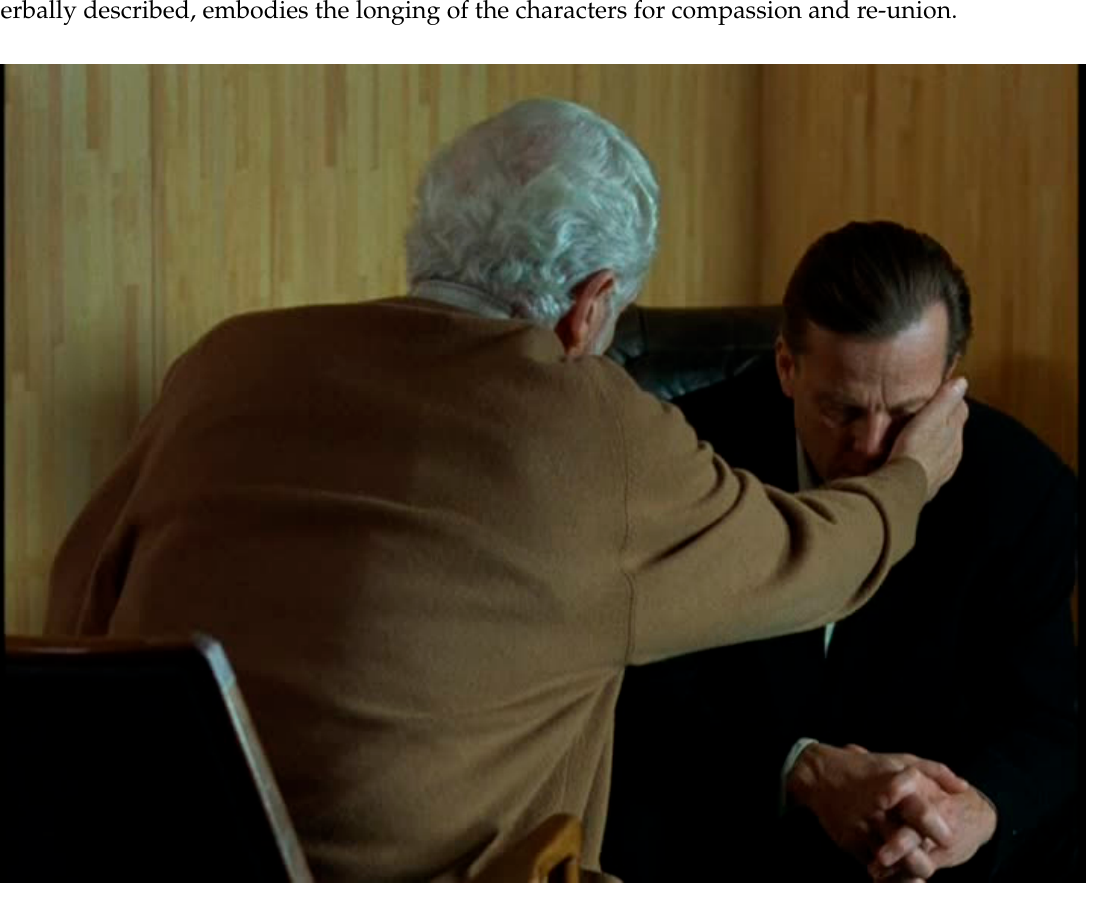
Figure 12. Reflexive Touch: Bergman/David.